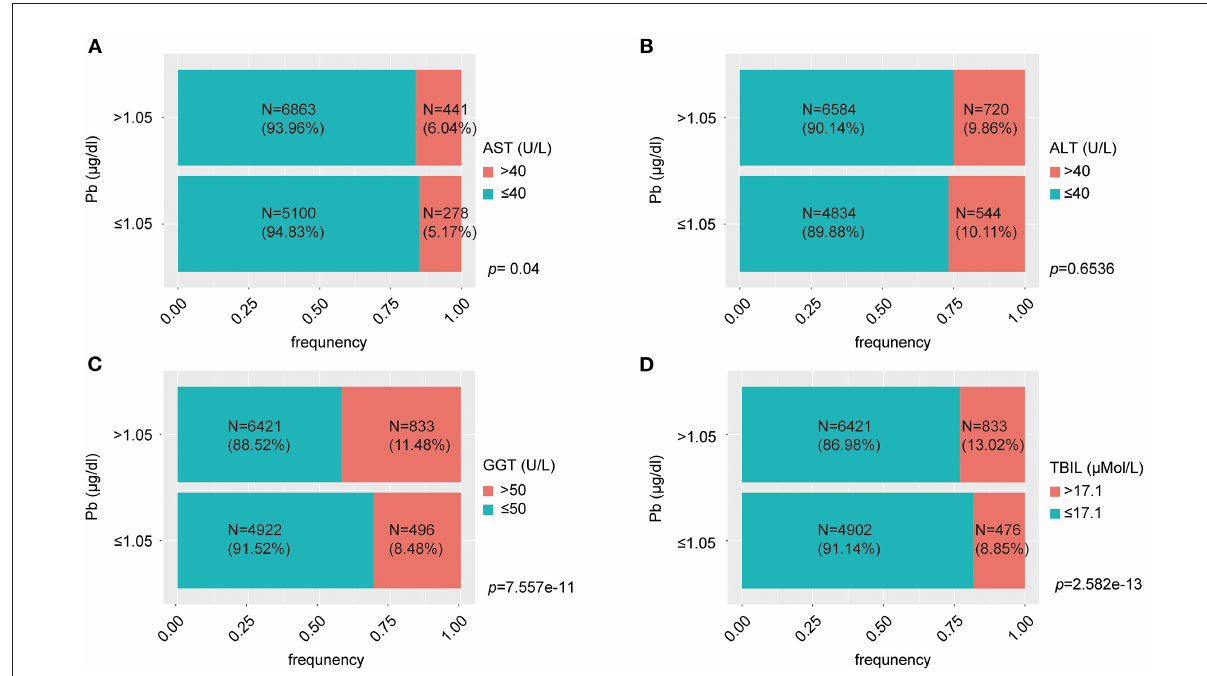
FIGURE3 The percent bar charts reflect proportion of normal and abnormal liver function at different levels of lead exposure. (A) The group with blood lead concentration > 1.5 µ g/dl had a greater proportion of individuals with AST > 40 U/L; (B) There was no significant difference in the proportion of individuals with ALT > 40 U/L between the high and low blood lead concentration groups; (C) The group with blood lead concentration > 1.5 µ g/dl had a greater proportion of individuals with GGT > 50 U/L; (D) The group with blood lead concentration > 1.5 µ g/dl had a greater proportion of individuals with TBIL > 17.1 µ